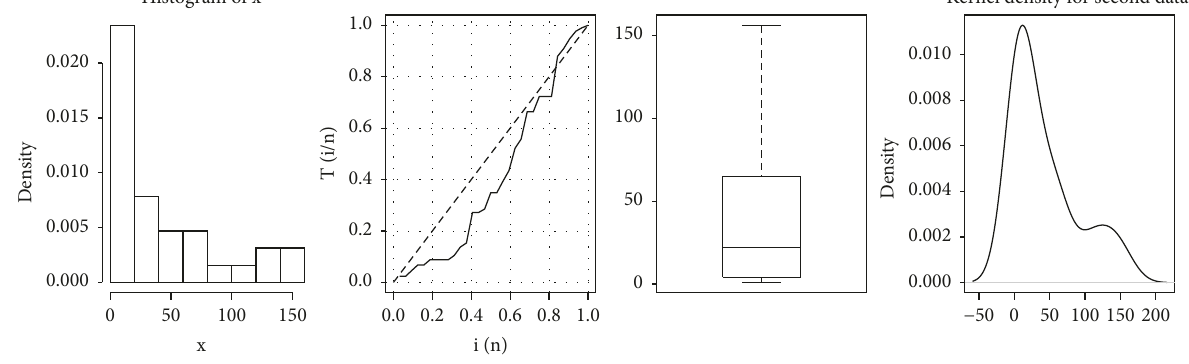
Figure 8: Histogram, TTT plot, box plot, and kernel density for survival time data.